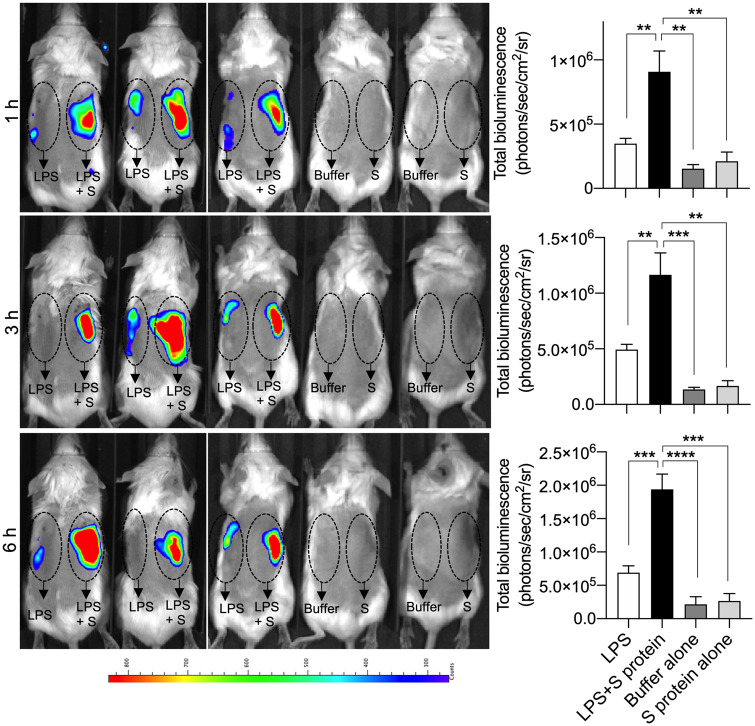
SARS-CoV-2 S protein combined with LPS boosts inflammation in NF-κB reporter mice. For in vivo inflammation imaging in NF-κB reporter mice, LPS alone or in combination with SARS-CoV-2 S protein (S) was subcutaneously deposited on the left or right side, respectively, on the back of transgenic BALB/c Tg(NF-κB-RE-luc)-Xen reporter mice. Noninvasive in vivo bioimaging of NF-κB reporter gene expression was performed using the IVIS Spectrum system. Representative images show bioluminescence at 1, 3, and 6 h after subcutaneous deposition. A bar chart shows measured bioluminescence intensity emitted from these reporter mice. Dotted circles represent area of subcutaneous deposition and region of interest for data analysis. Data are presented as mean ± SEM (n = 5 mice for LPS group, 5 mice for LPS and S protein group, 3 mice for buffer control, and 3 mice for S protein control). P-values were determined using a one-way ANOVA with Holm-Sidak posttest. **P ≤ 0.01, ***P ≤ 0.001, ****P ≤ 0.0001.